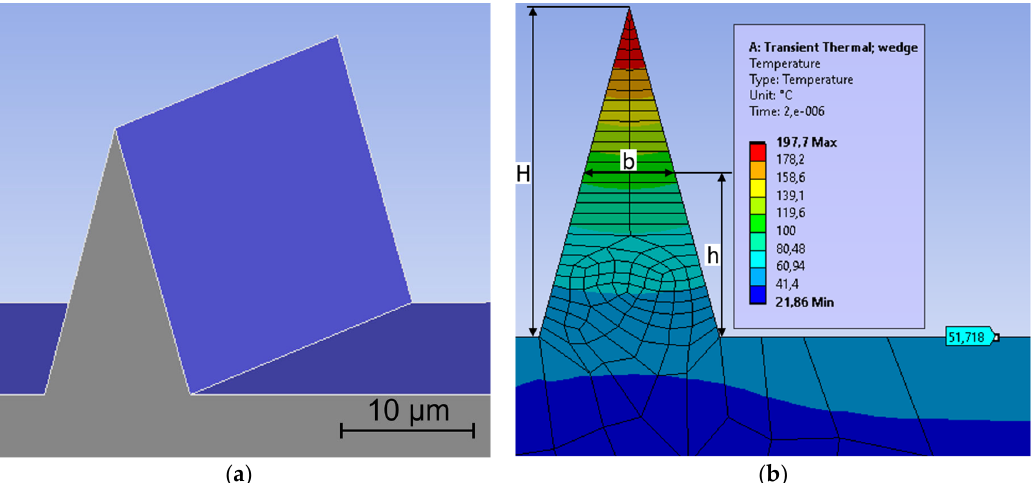
Figure 2. Heat transfer simulations in ANSYS. ( a ) Isometric view of a standing feature. The heat flux is applied on the blue surfaces. ( b ) Temperature profile for a standing feature with a height (H) of 15 μ m and a 30° angle. H is the standing feature height, h is the measurement height, and b is the local width at measurement height h.